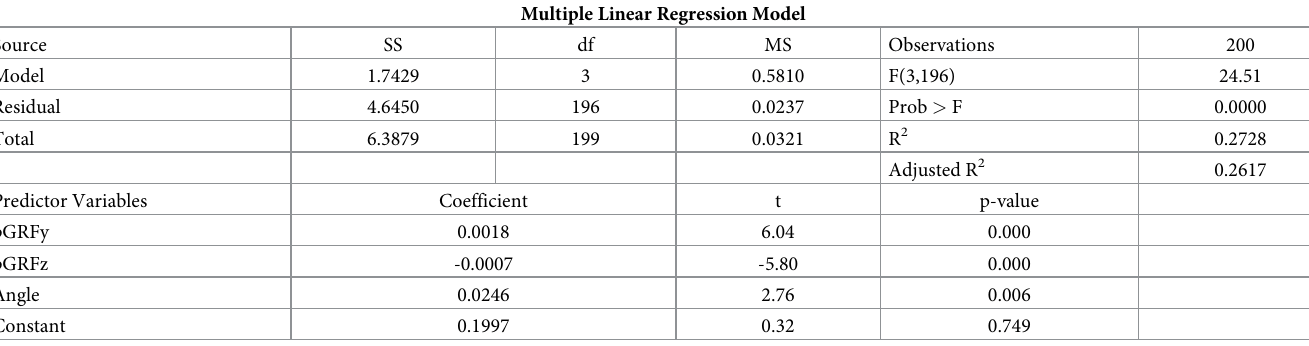
Table 3. Multiple linear regression model predicting lateral jump distance; derived with full trial set, absolute